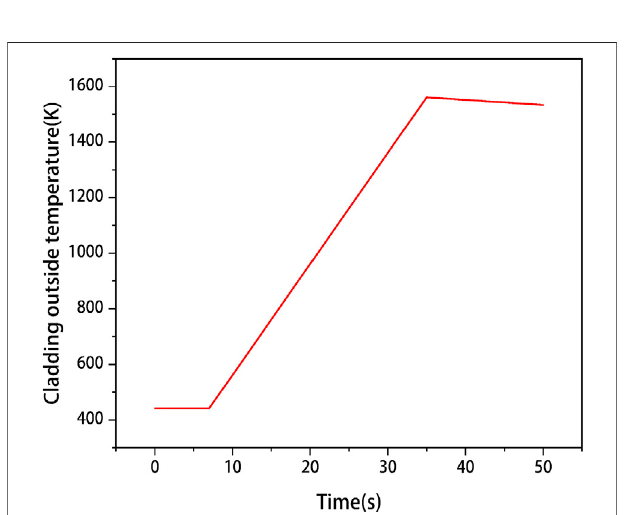
FIGURE 2 | Cladding the outer surface temperature of the UO 2 fuel with Zircaloy cladding used to calculate under the LOCA condition.